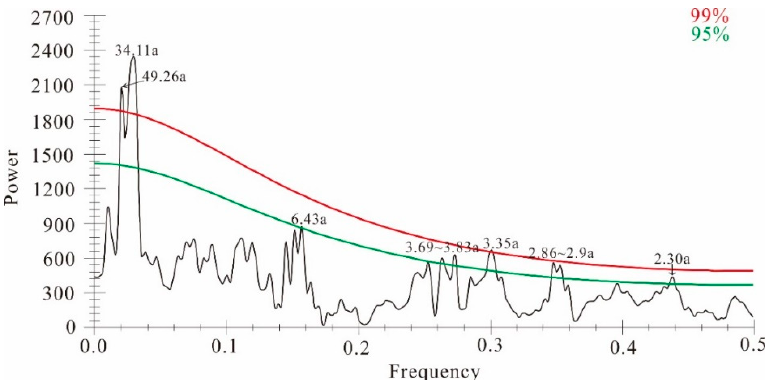
Figure 5. Results of the MTM power spectrum from reconstructed scPDSI MJ from 1801 to 2016 CE. The red and cyan lines indicate 99% and 95%, respectively. “a” in 2.30a on the curve stands for “annual”.